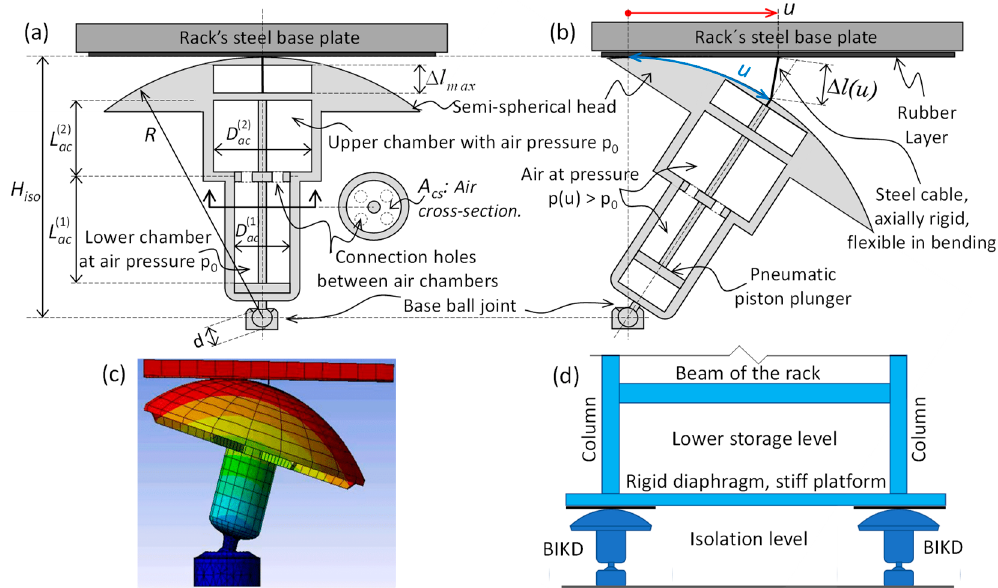
Figure 4. Scheme of the BIKD used with a compressed pneumatic piston as elastic element ( a ) undeformed equilibrium po-